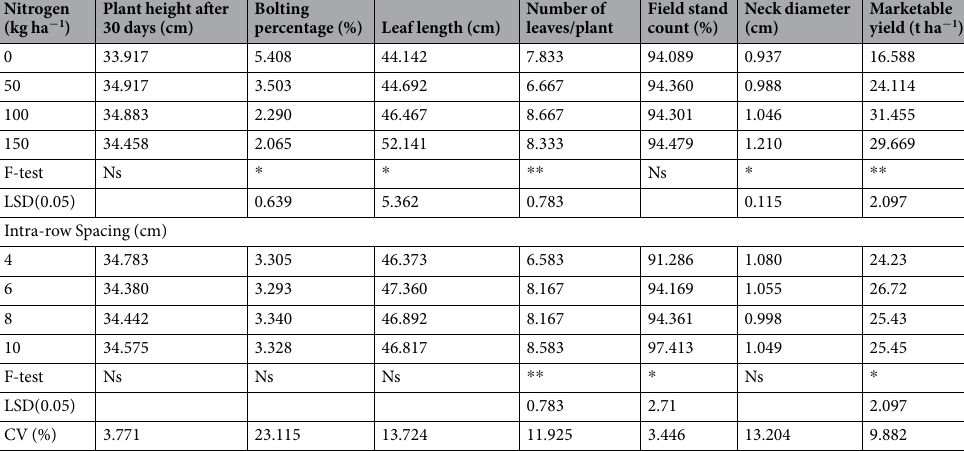
Table 3. The effects of nitrogen and intra row spacing on plant height, bolting percentage, leaf length, number of leaves per plant, field stand count, neck diameter and marketable yield. Means in columns sharing a common letter are not significantly different at 5% level of significance Ns = non-significant. * , ** , significant at 5% and 1%